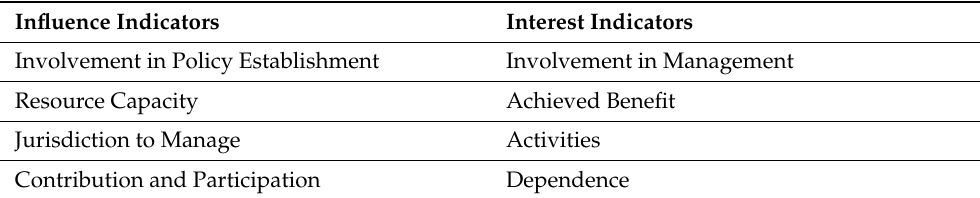
Table 1. Adapted scoring indicators [23,24] for stakeholder mapping tools in the Gili Matra MPA. Each indicator will provide 1–5 scores; thus, the total score for each axis in the grid has a maximum score of 20.